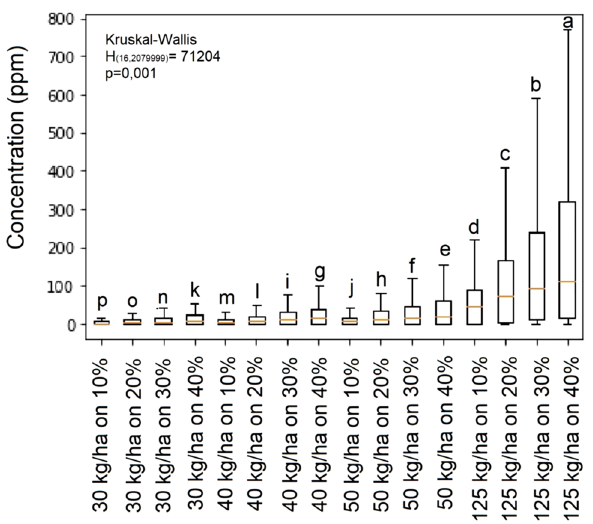
Fig. 13 N fixation in the crops in each of the treatments 2